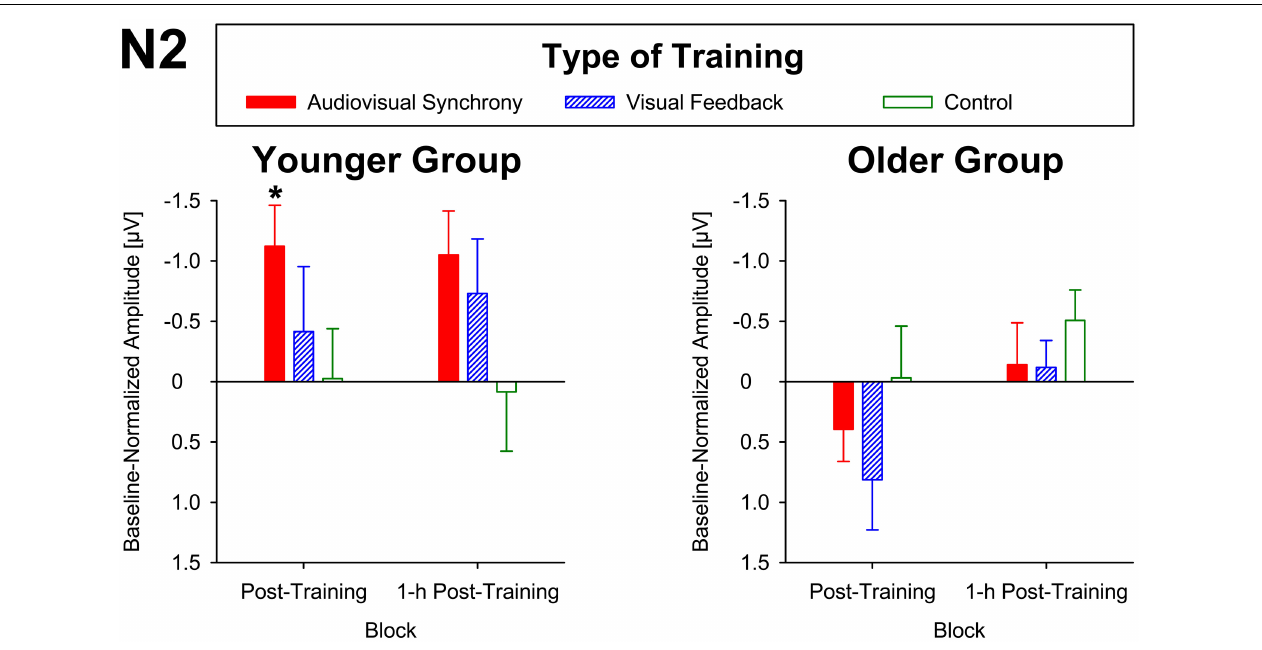
FIGURE 3 | Baseline-normalized N2 peak amplitudes at electrode position Cz in younger and older participants. Post-training and 1-h post-training data are shown separately for audiovisual-congruency training, visual-feedback training, and control condition. A significant negative deviation from zero was found exclusively in the post-training block after audiovisual-congruency training in the younger group, * p <